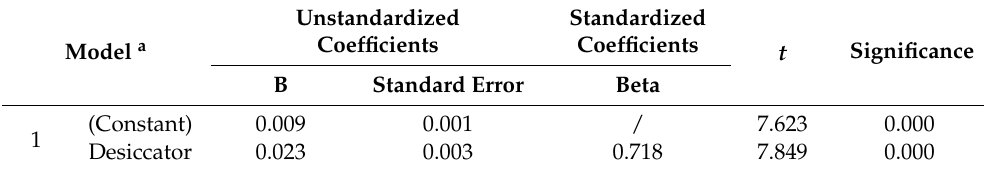
Table 5. Variance analysis of regression model of formaldehyde emissions between desiccator and climate chamber. Model DOF Sum of Squares Mean Square F p Regression 1 0.001 0.001 61.609 Residual 58 0.001 0 / / In total 59